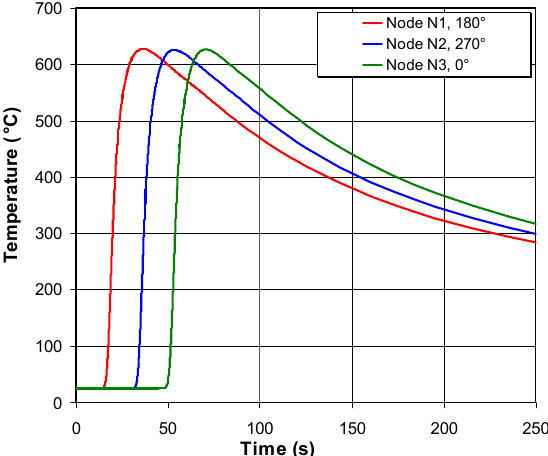
Figure 8. Full field residual stress distribution; ( a ) axial residual stress—global model, ( b ) axial re- sidual stress—submodel, ( c ) hoop residual stress—global model, ( d ) hoop residual stress—submodel.